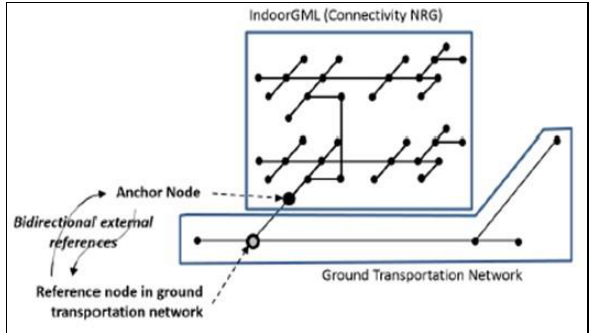
Figure 5. Anchor node connecting indoor and outdoor space networks (OGC,